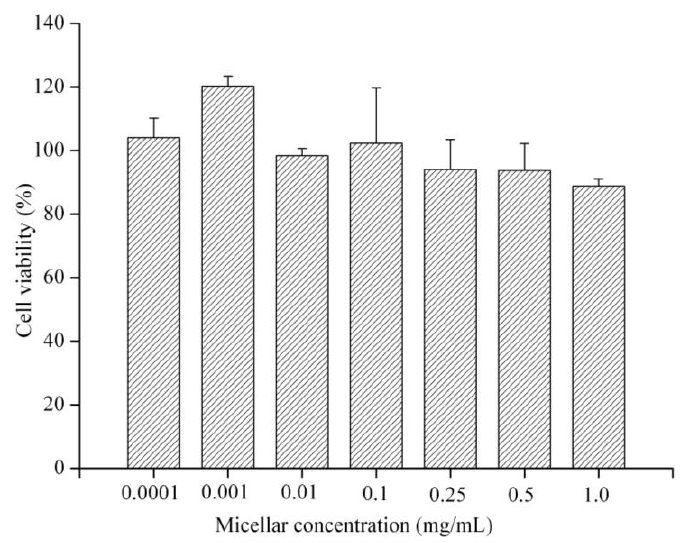
Figure 4. The cytotoxicity of PEG-PCL-PEG micelle against MCF-7 cells. Data represents the mean ± standard error of the mean of four measurements ( p > 0.4 compared to